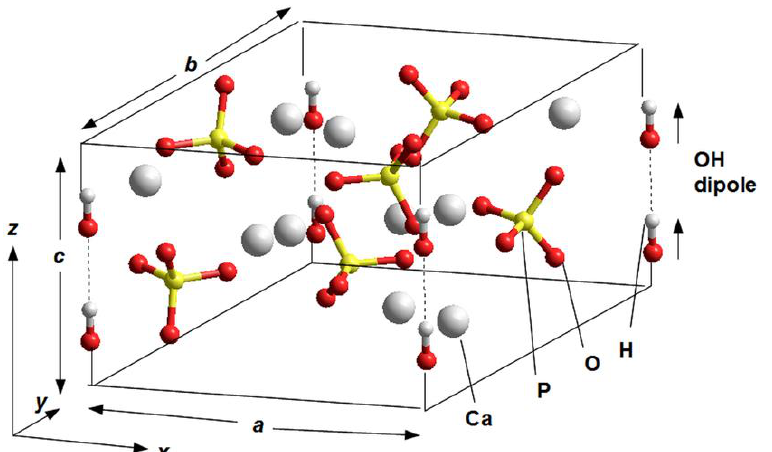
Figure 1. One unit cell model of the Hydroxyapatite (HAP: Ca 10 (PO 4 ) 6 (OH) 2 ) — in P6 3 hexagonal phase. All OH groups are oriented in the same direction. They are positioned at the four corners of the unit cell, but only one pair in one corner belongs to this elementary unit cell; the other three pairs belong to neighboring unit cells (here the atoms are color-marked: gray — Ca, red — O, yellow — P, white — H). (Adapted with permission from ref. [8]; IOP Publishing, 2015).